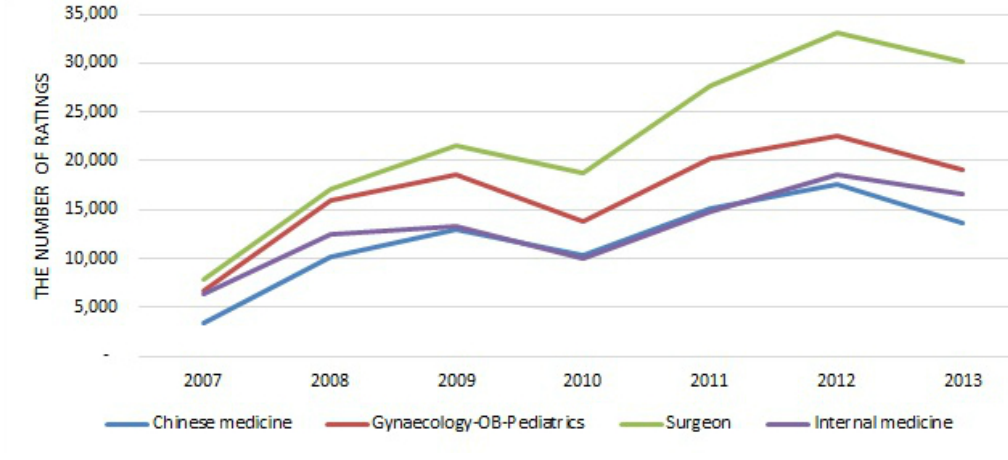
Figure 7. Number of ratings over time among four major specialty areas.